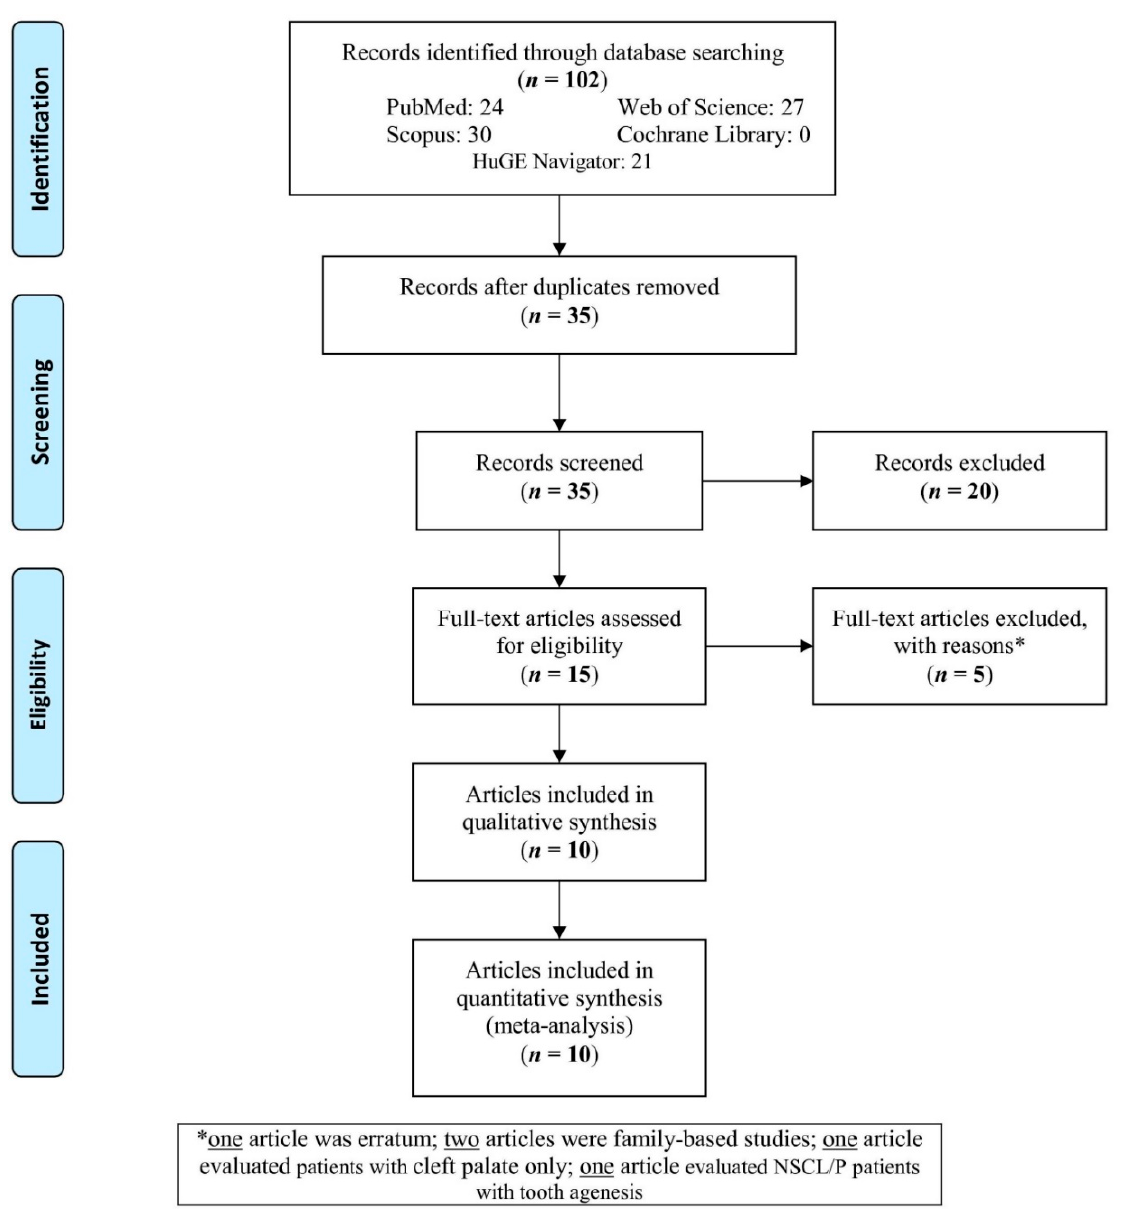
Figure 1. Flow-chart of the article Figure 1. Flow ‐ chart of the article selection.